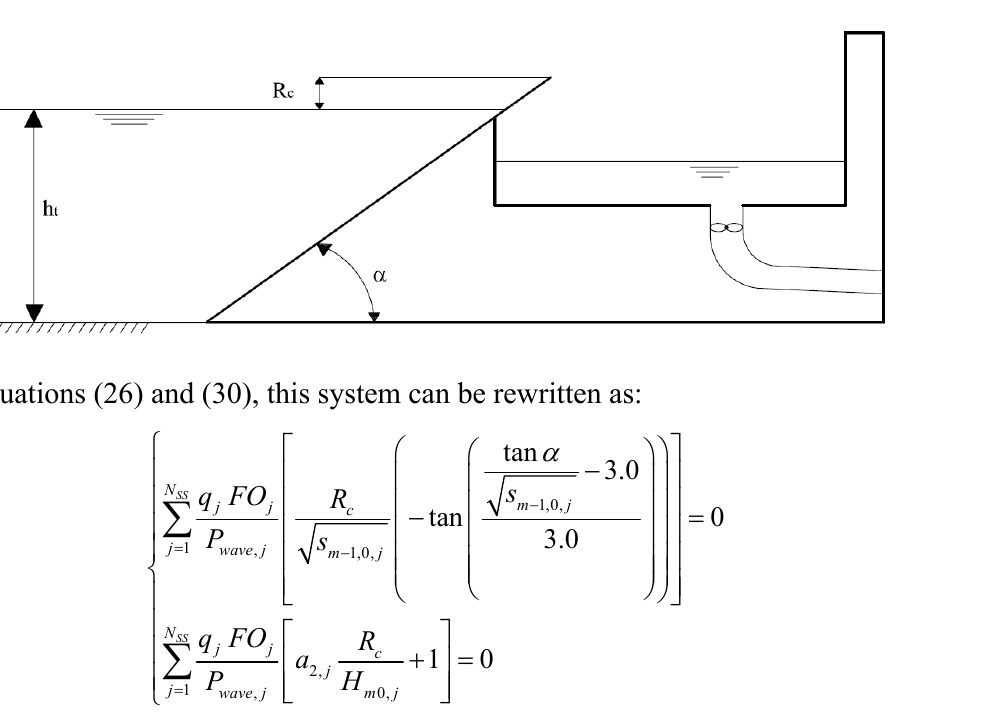
Figure 6. Scenario 4—No geometry control—Fixed slope angle and fixed crest freeboard (S4).